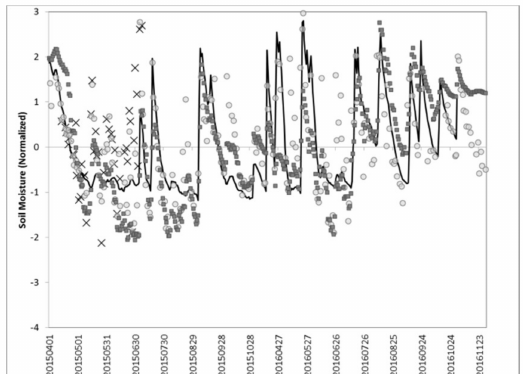
Figure 3. Time series of normalized surface soil moisture from three SMAP data sets for sites in Ontario ( Top Left ), Manitoba ( Right ), and Alberta (Wrentham site, Bottom Left ). Soil moisture was normalized for each data set to compare data sets as indicators of relative trends. The Alberta Wrentham site was selected for display as it represented average results for Alberta. The SMAP_P36 trends where not shown since they were very similar to